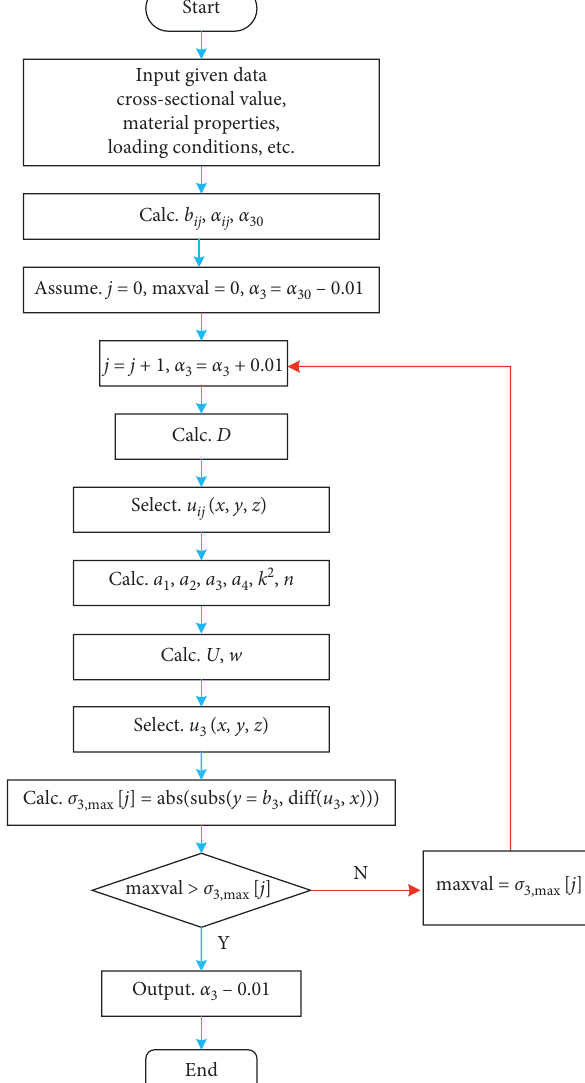
Figure 4: Flowchart of the coefficient of shear lag warping function α